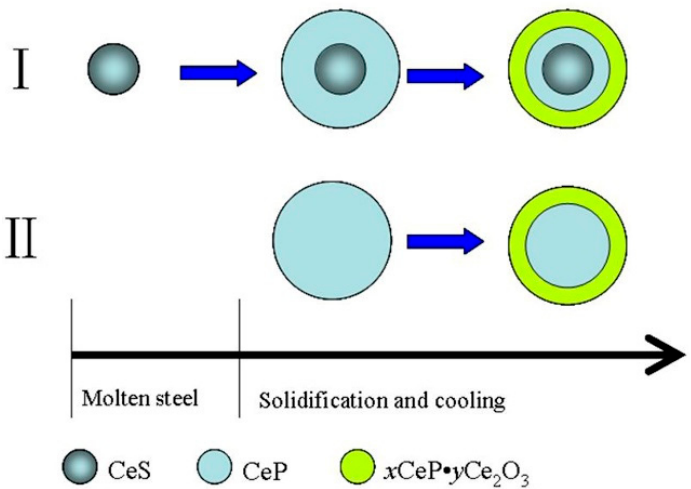
Figure 13. Mechanism diagram of composite inclusions of I-type inclusion (Ce–S–O–P (As) inclusions)